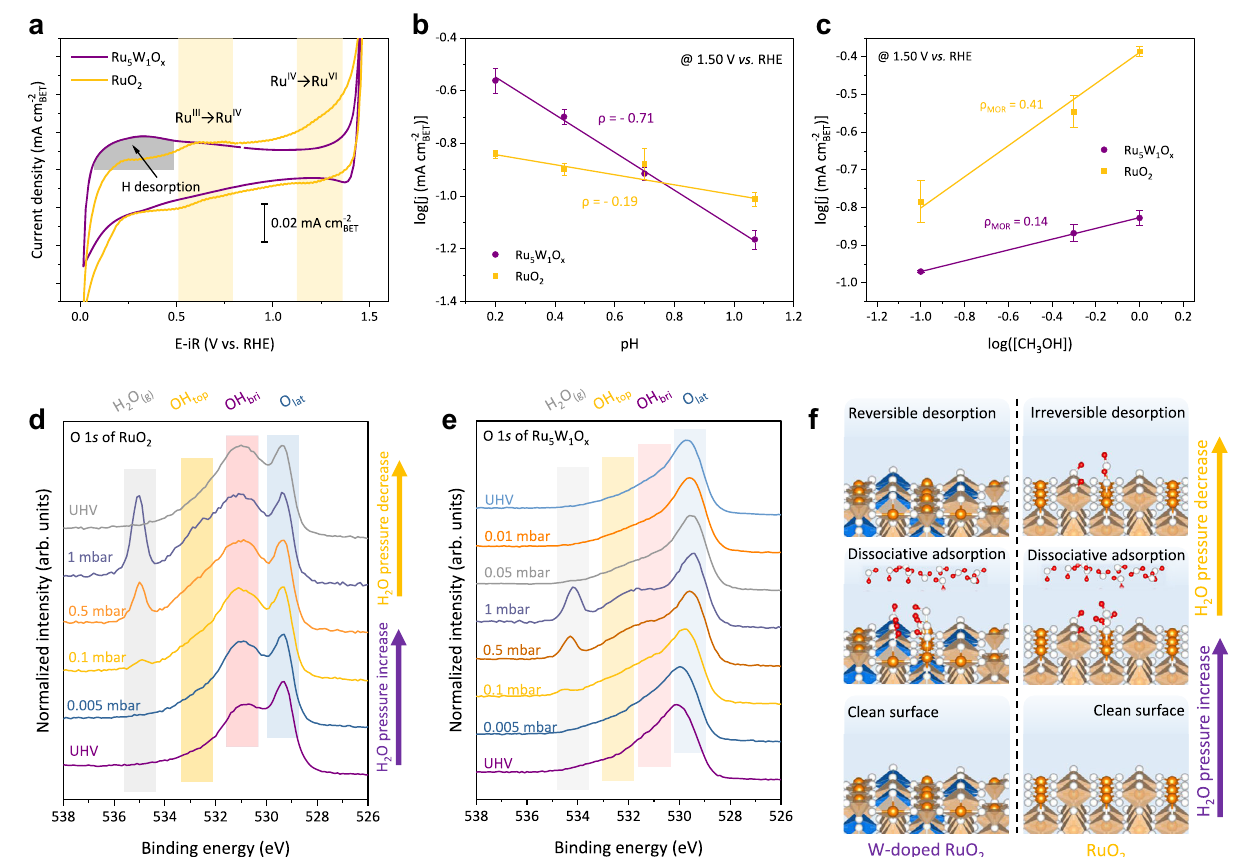
Fig. 3 | Investigationofdeprotonationon bridging oxygen. a Typical CV curves ofRu 5 W 1 O x andRuO 2 .Scanrate:200mVs − 1 . b LogarithmofOERactivityat1.50V vs . RHE as a function of pH. c The logarithm plots between MOR current density and concentrationofmethanolondifferentcatalysts.Thecurrentdensitiesin a – c were normalized by BET surface area. The error bars in b , c are standard deviations of averagingthreeindependentmeasurements. d,e TheO1 s XPSspectraofRuO 2 and